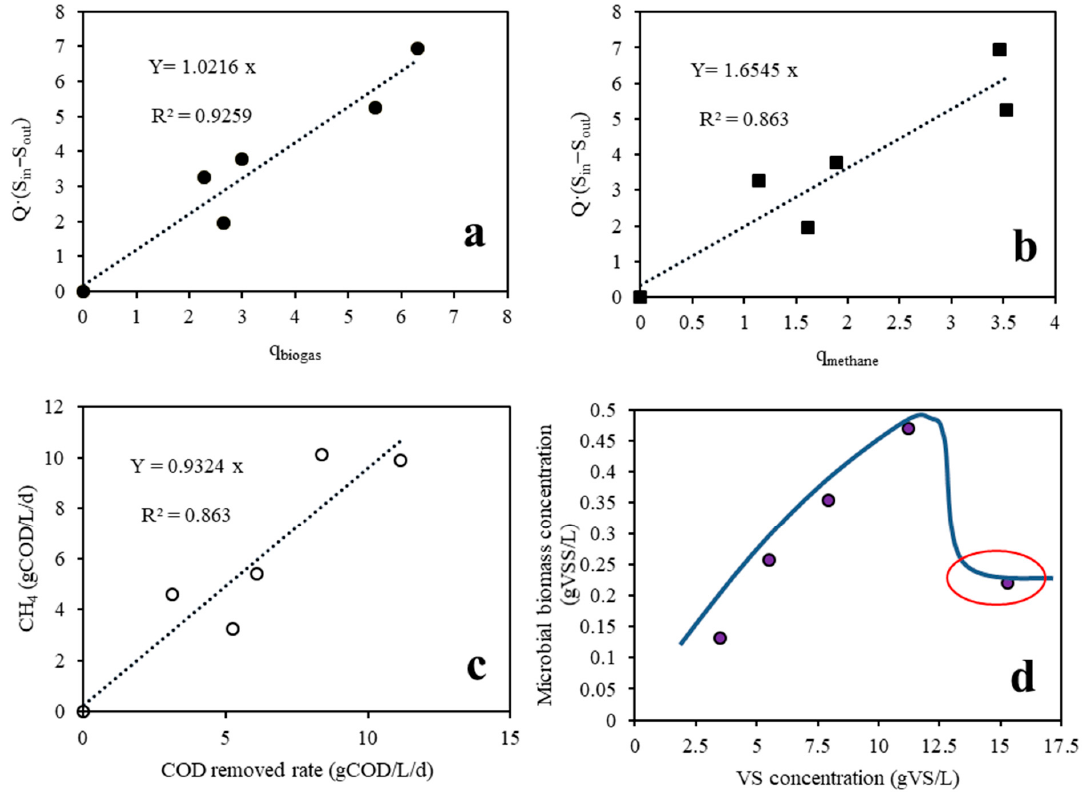
Figure 6. ( a ) Variation in Q · (S in − S out ) as a function of daily biogas production; ( b ) Variation in Figure 6. (a) Variation in Q·(S in − S out ) as a function of daily biogas production; (b) Variation in Q·(S in 345 Q · (S in − S out ) as a function of daily methane production; ( c ) VMPR as a function of the volumetric COD − S out ) as a function of daily methane production; (c) VMPR as a function of the volumetric COD 346 removal e ffi ciency; ( d ) Variation in the calculated microbial biomass concentration as a function of the removal efficiency; (d) Variation in the calculated microbial biomass concentration as a function of 347 the VS concentration. 348 VS